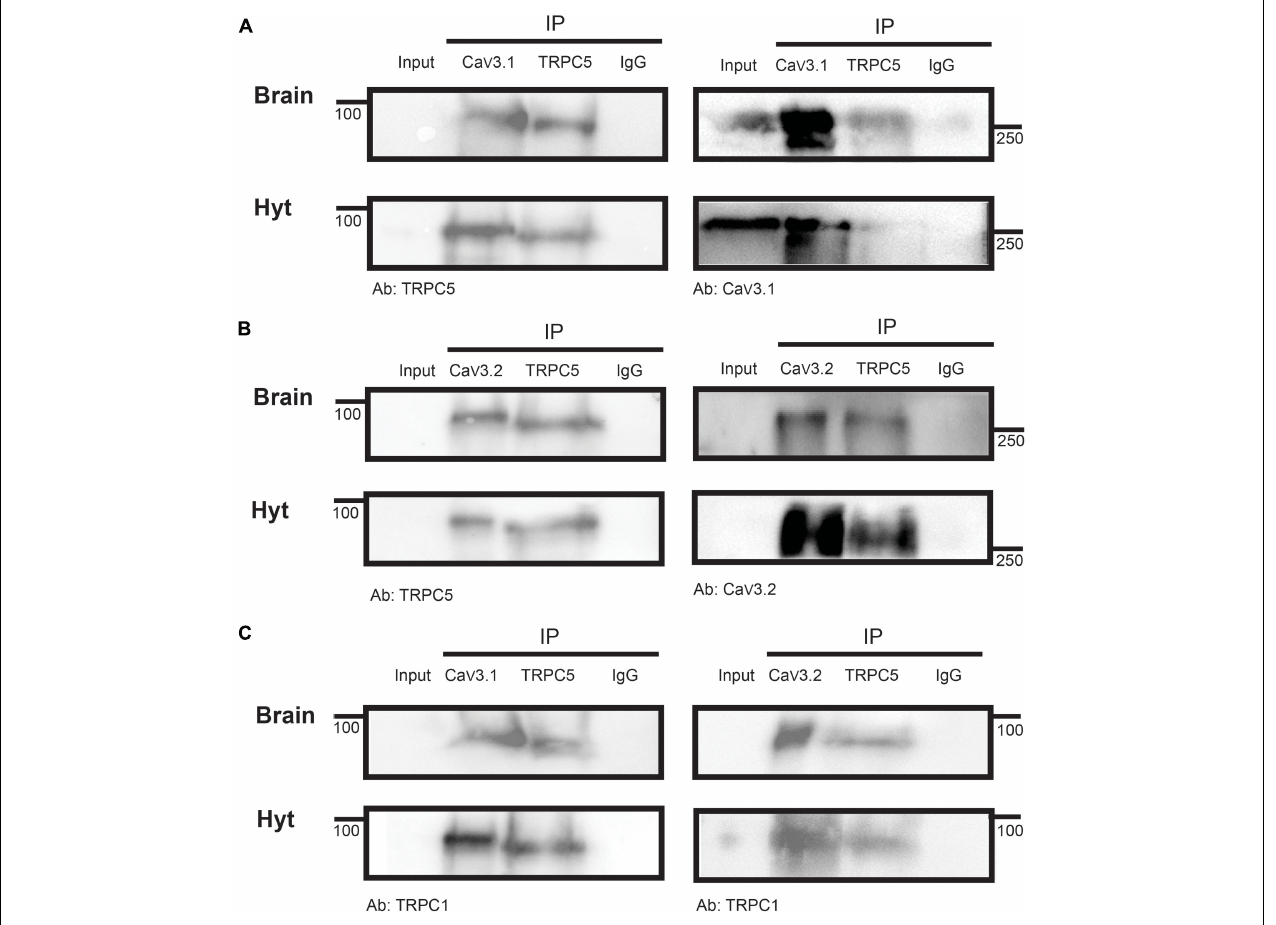
FIGURE 6 | Ca V 3 co-precipitation with TRPC5. Immunoprecipitation of brain and hypothalamus (Hyt) extracts with Ca V 3.1 (A) or Ca V 3.2 (B) and TRPC5 in the same samples show their mutual interaction. (C) IP of brain and Hyt samples using Ca V 3.1 (left) or Ca V 3.2 (right) and TRPC5 show their interaction with TRPC1. IgG was used as IP negative control in all cases, ( n = 3 for all